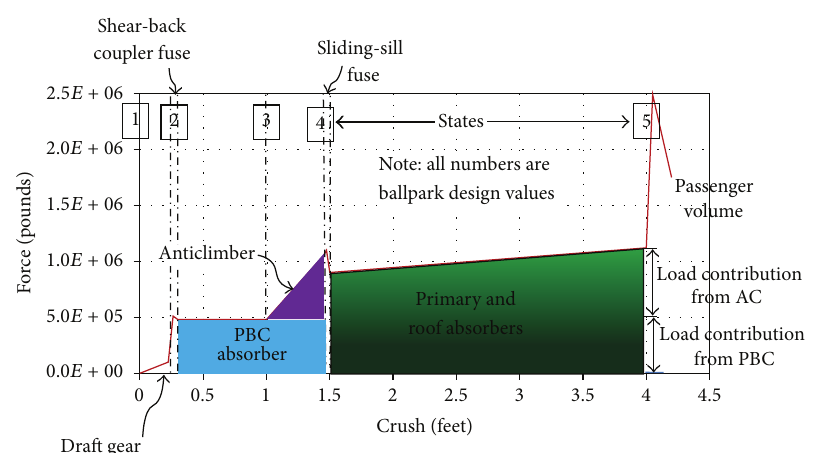
Figure 8: Force-crush characteristic.